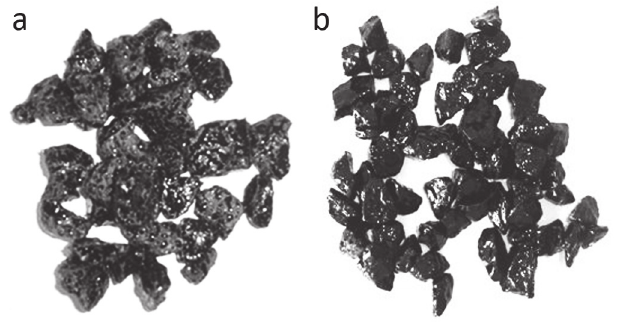
Fig. 5 - Samples analyzed in the adhesion tests with (a) aggregate- pure asphalt binder system and (b) aggregate-mastic system with 6.0% of limestone